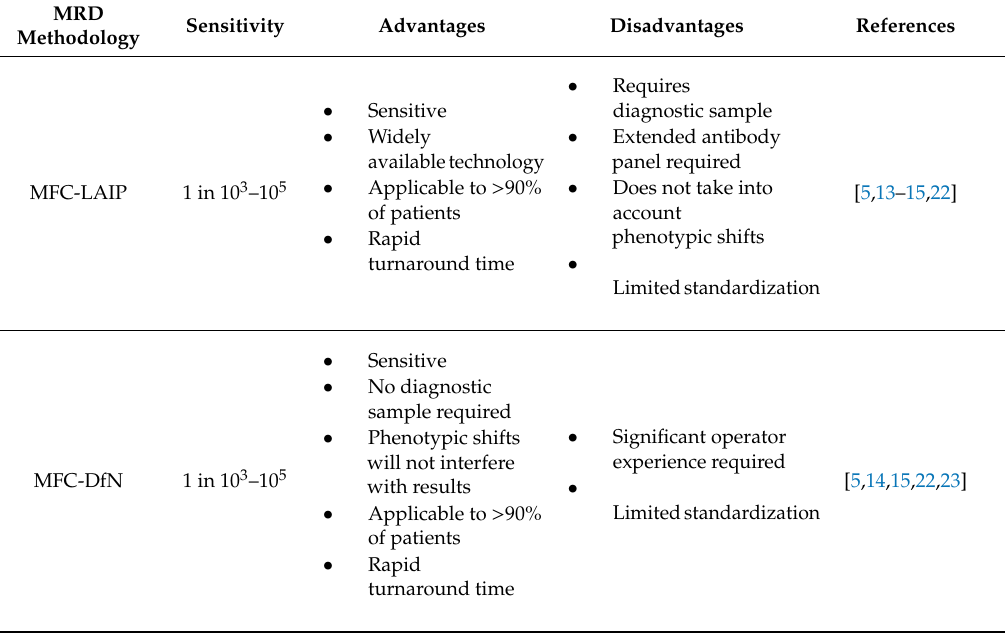
Table 1. Comparison of methods used for measurable residual disease (MRD)